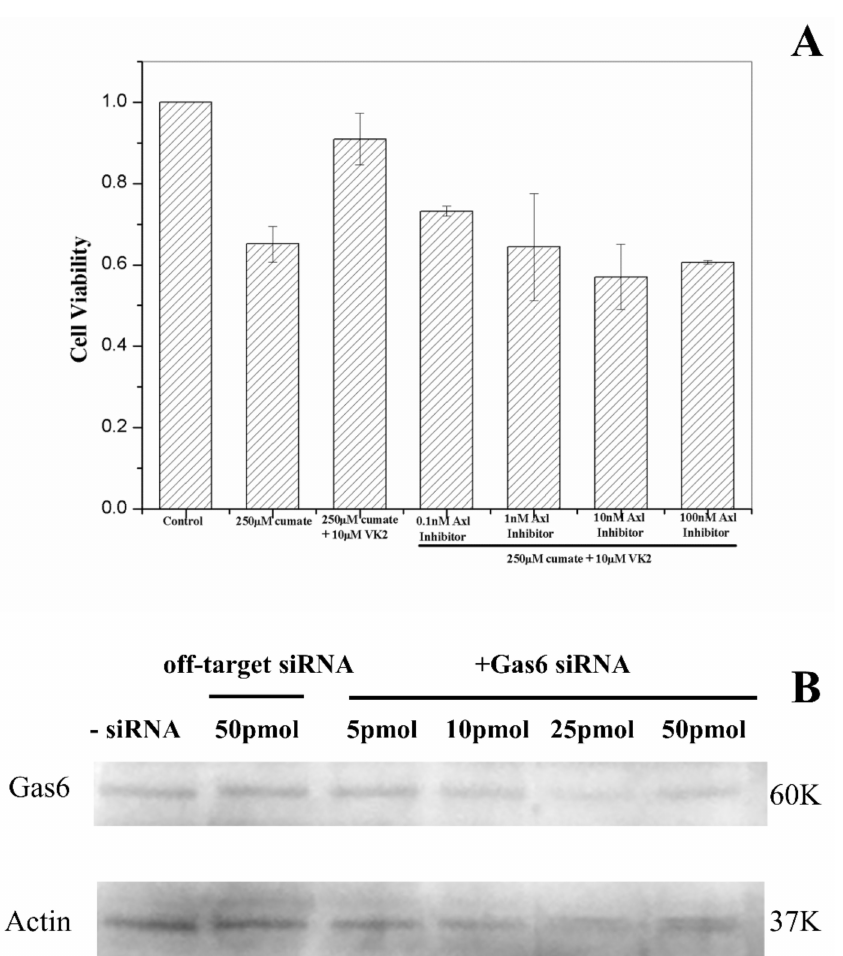
Figure 8. ( A ) Effect of Axl inhibitor on vitamin K2-dependent protection. β -CTF/C6 cells were incubated for 72 h with 250 µ g cumate, 10 µ M vitamin K2 (MK4) and various concentrations of Axl inhibitor. The cell survival rate was determined by MTT assay. ( B ) Effect of Gas6 activity on vitamin K2-dependent protection. ( A ) The knockdown of Gas6 protein treated with 5–50 pmol of Gas6 siRNA and 50 pmol of off-target